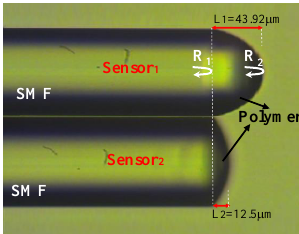
Figure 1. Configuration of the proposed dual-polymer fiber Fizeau interferometer (DPFFI) sensor.